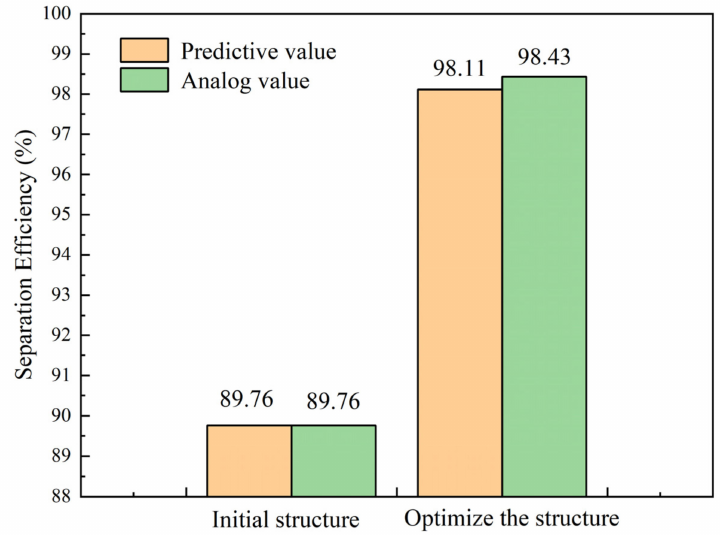
Figure 10. Comparison of separation efficiency of downhole cyclone separator before and after